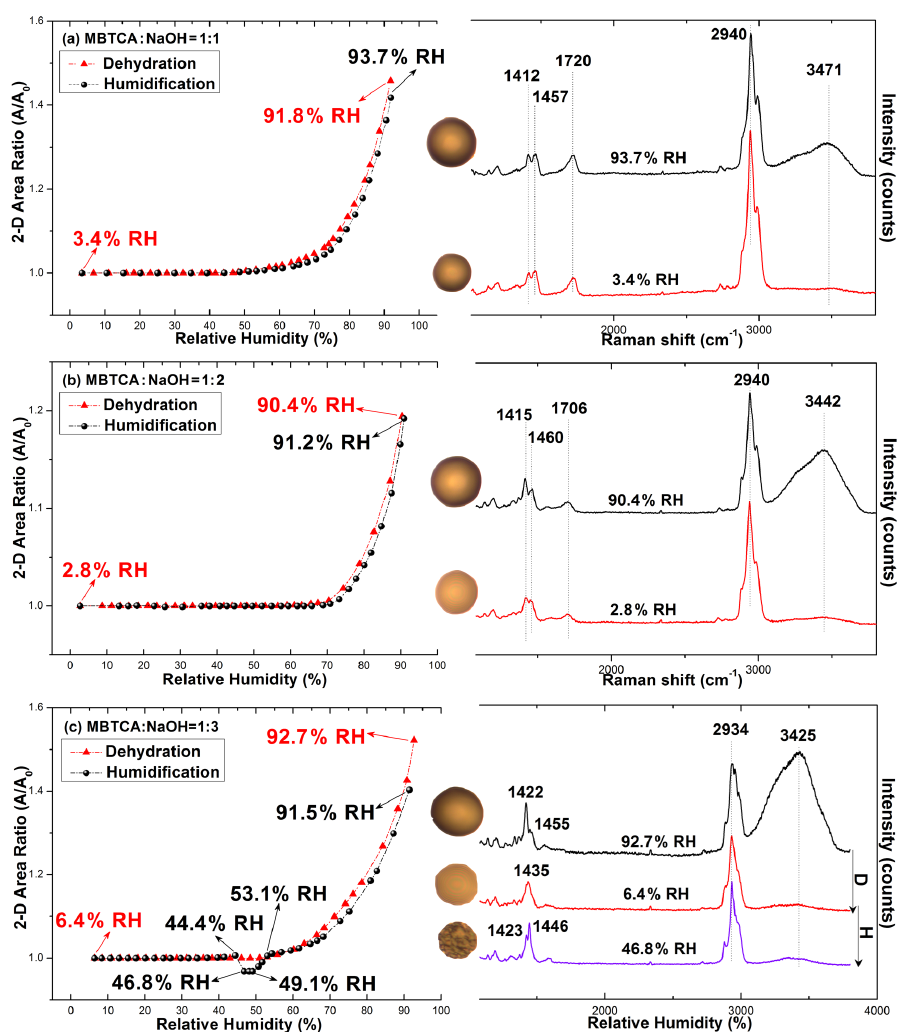
Figure 3. Hygroscopic curves, corresponding optical images, and Raman spectra at specific RHs of (a) mono-, (b) di-, and (c) trisodium MBTCA salt aerosols. The recorded transition RHs during the dehydration and humidification processes are marked with arrows in the hygroscopic